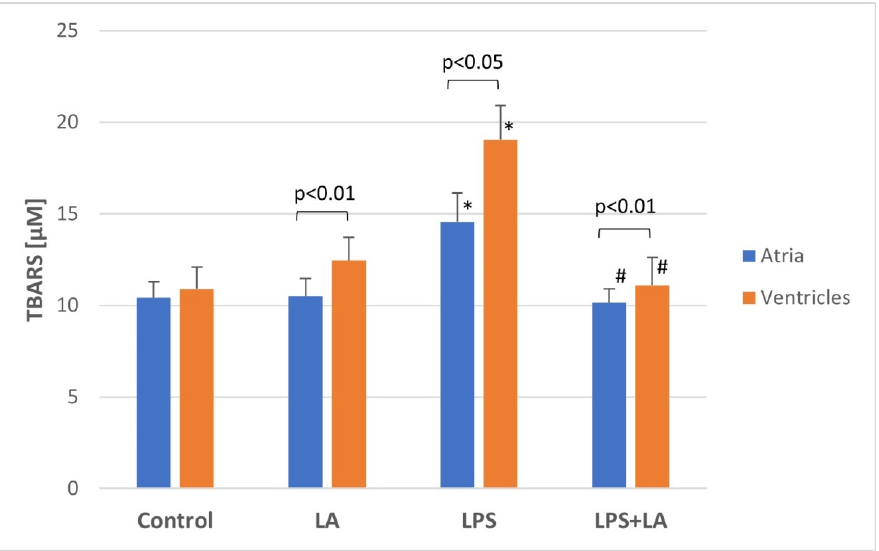
Figure 4. Effect of LA, LPS, and LPS + LA on TBARS levels in ventricular and atrial homogenates. Results are shown as mean ± S.E.M. n = 8. * p < 0.05 vs. control, LA; # p < 0.01 vs. LPS. LA—alpha lipoic acid,